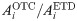
Ratio AiOTC/AiETD versus ranks R
i based on the total activity A
i.